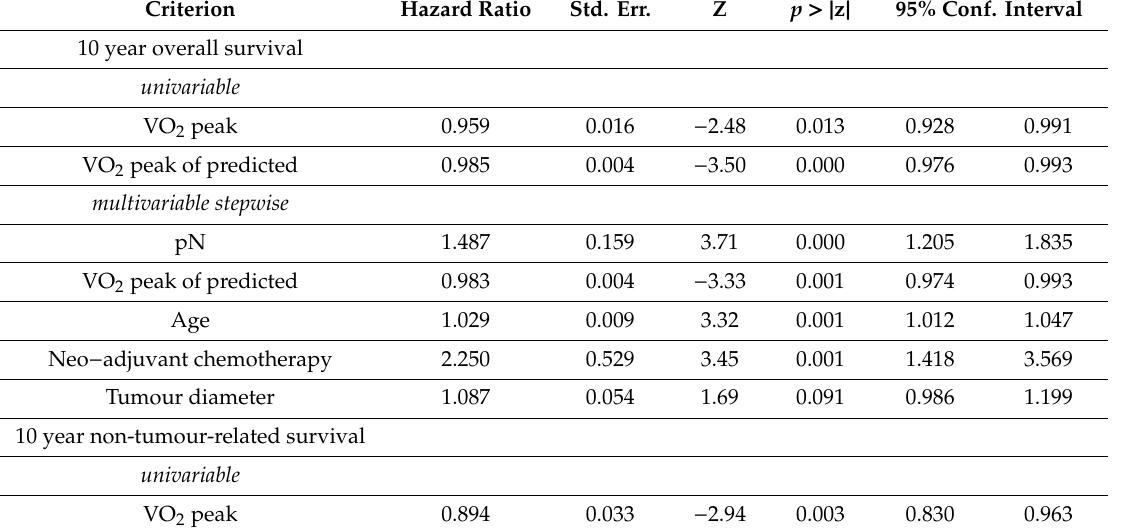
Table 5. Univariable and multivariable prognostic analysis using Cox’ proportional hazard